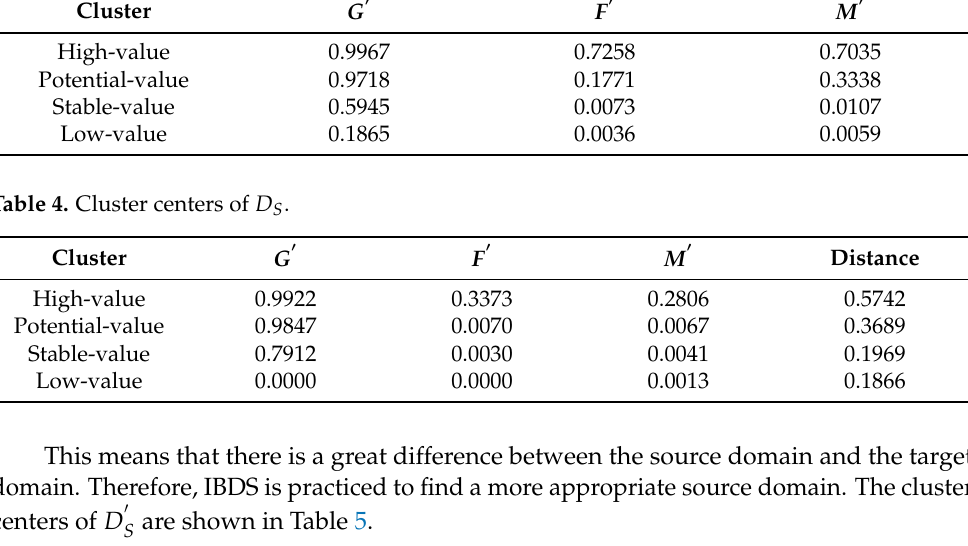
Table 5. Cluster centers of D (cid:48)